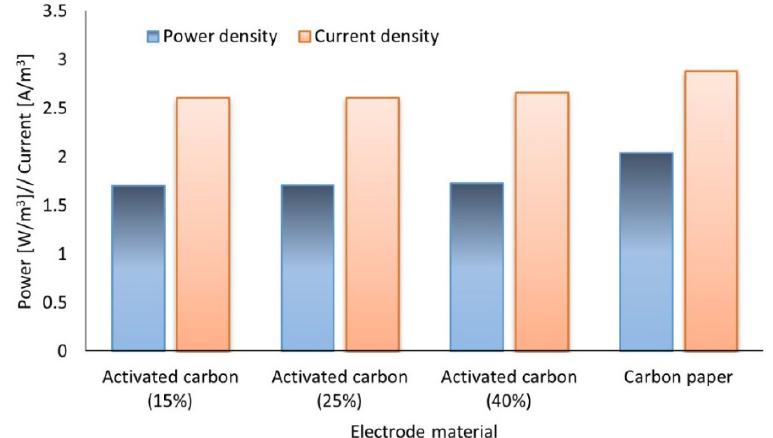
Figure 7. Performance of palm kernel shell AC (various granular volumes) relative to CP (standard) tested in an MFC.